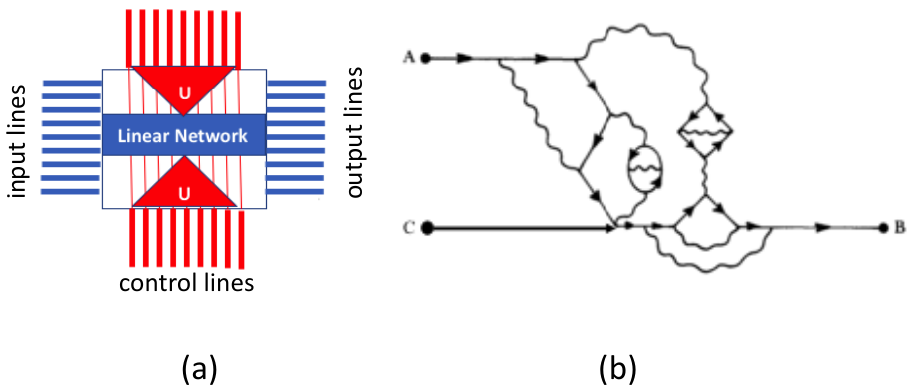
Figure 7. The figure on the left ( a ) is schematic diagram to explain the dynamics of the I/O behavior of the PZT cube. Signals on the input lines are read out on the output lines where we observe a linear superposition of the inputs. When signals are applied to the control lines they act as a scattering matrix U, which scrambles the input in a controlled and reproducible way. The figure on the right ( b ) is an example of a Feynman diagram and simply represents the electron phonon scattering suggesting the type of complex dynamics taking place inside the cube at the nano-scale. Position A represents the input data, Position B represents the output data, and Position C represents the control signals. The figure on the right is modified and based on (Hofstadter 1979) [41].